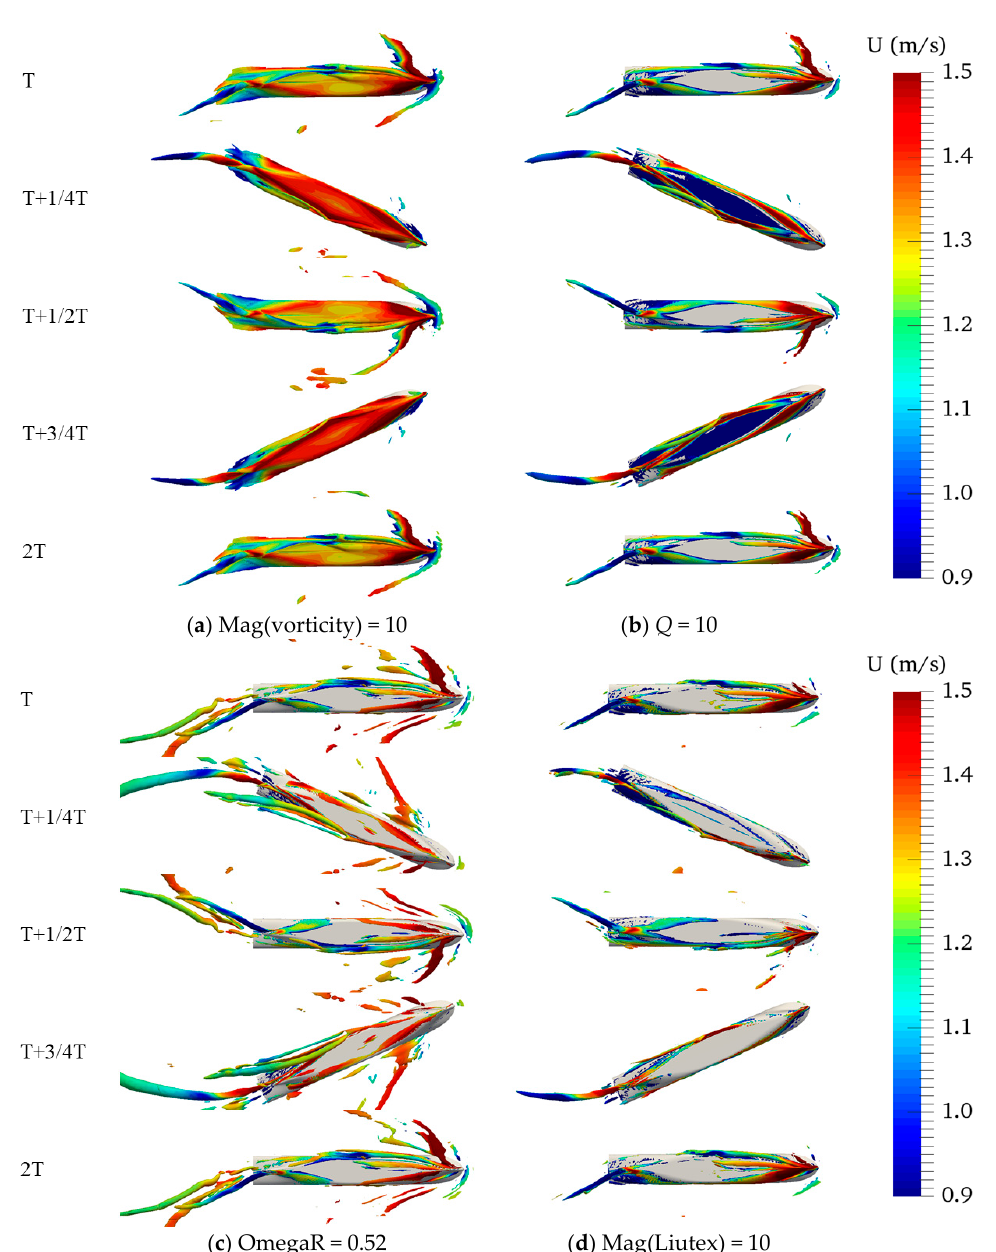
Figure 18. Vortex structures obtained by different vortex identification method: ( a ) first generation based on vorticity; ( b ) second generation based on eigenvalues; ( c , d ) third generation in CASE PY8.